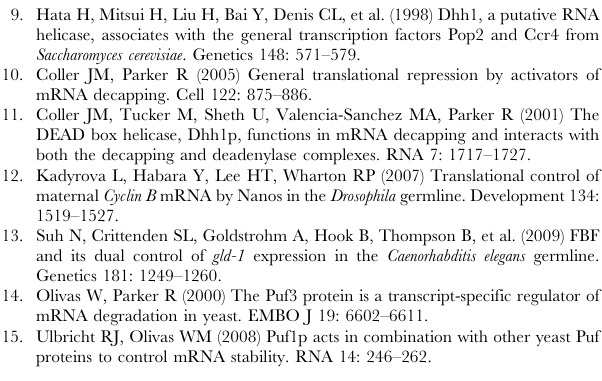
Figure S2 Suppression of pop2 D phenotypes by multi-copy Puf5 Wild type (wt) or pop2 D mutants were transformed with pMPT5 (2 m , URA3 ) or pRS426 vector only control (2 m , URA3 ) and dropped on -Ura plates with or without caffeine and HU. Cells were photographed after five days of growth at 30 u C. Figure S3 The phenotypes of puf5 D are more pronounced in the W3031-A strain background Cells of wild type and puf5 D mutants in the W3031-A background were dropped on caffeine or HU containing plates and photographed after three days of